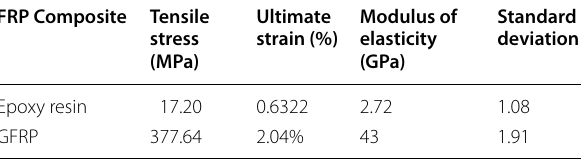
Table 2 Mechanical properties of epoxy resin and GFRP